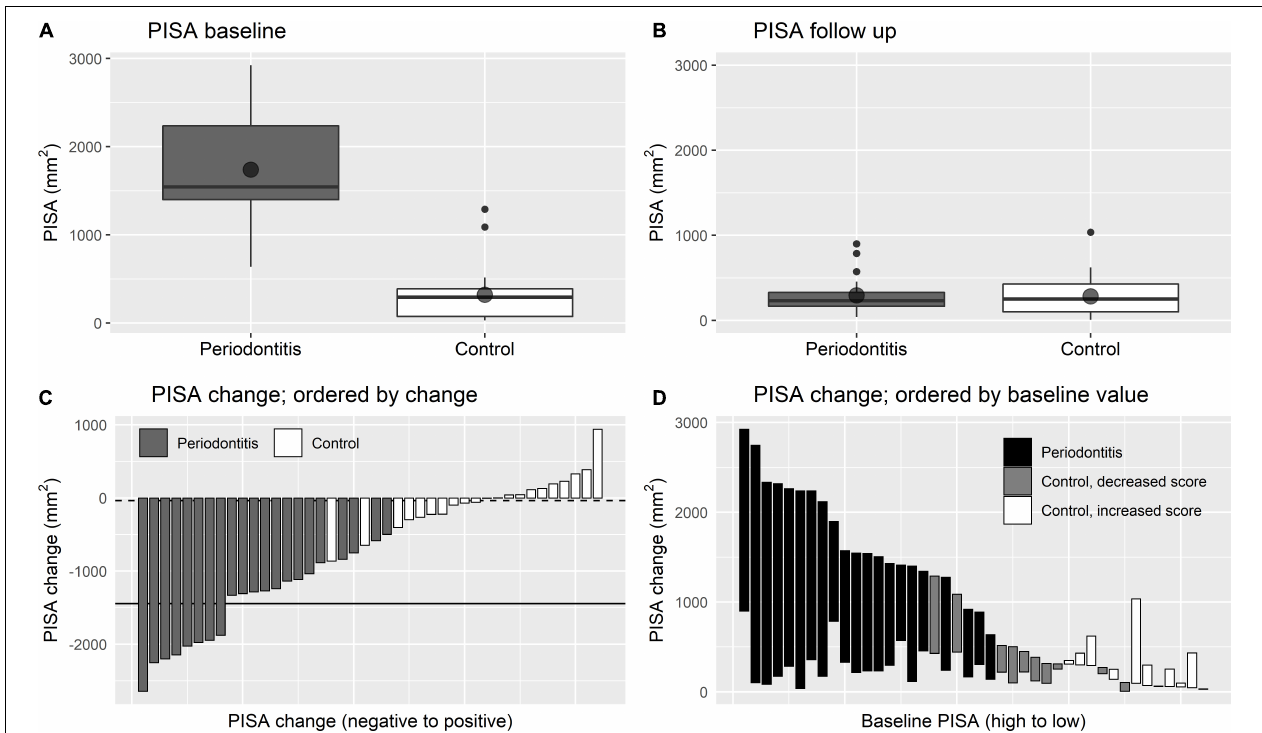
FIGURE 1 | Changes in PISA score. (A,B) Are boxplots showing the distribution of PISA score at baseline and at follow up, respectively. Point shapes indicate sample means. (C,D) Are waterfall plots showing the change of PISA score while ordered by the extent of PISA change and ordered by baseline PISA score, respectively. In (C) the solid line indicates mean PISA change for periodontitis patients and the dashed line indicates mean change for controls.